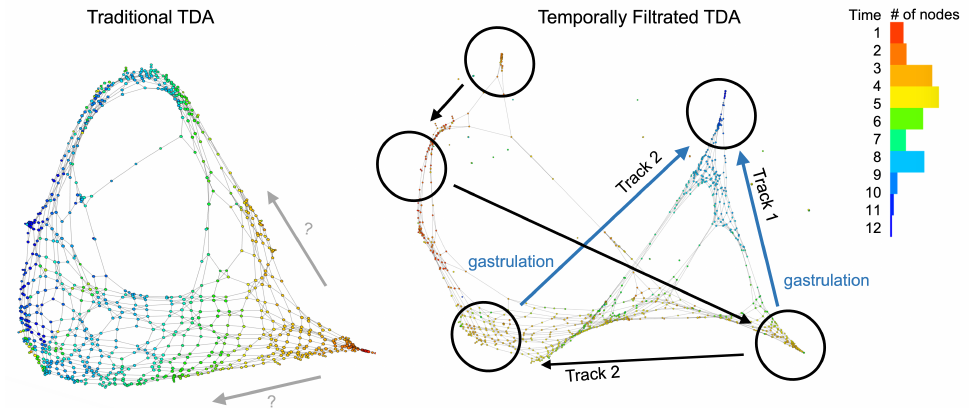
Figure 9. Temporal filtration identifies the critical stage of cellular complexity change. The colors indicate the time points, and each node corresponds to a small cluster of cells collected at the same time points. The conventional TDA mapping (the left panel) identifies a bifuraction structure, but there are spatial locations that have a mixture of clusters that belong to non-consecutive time points. This makes the identification of a developmental pathway challenging. When applying the temporal filtration (the right panel), the mapping identifies a clean separation of two tracks, or two sub- populations of cells that evolve in the gastrulation stage, matching the observation in our summary statistics from the algebraic topology.